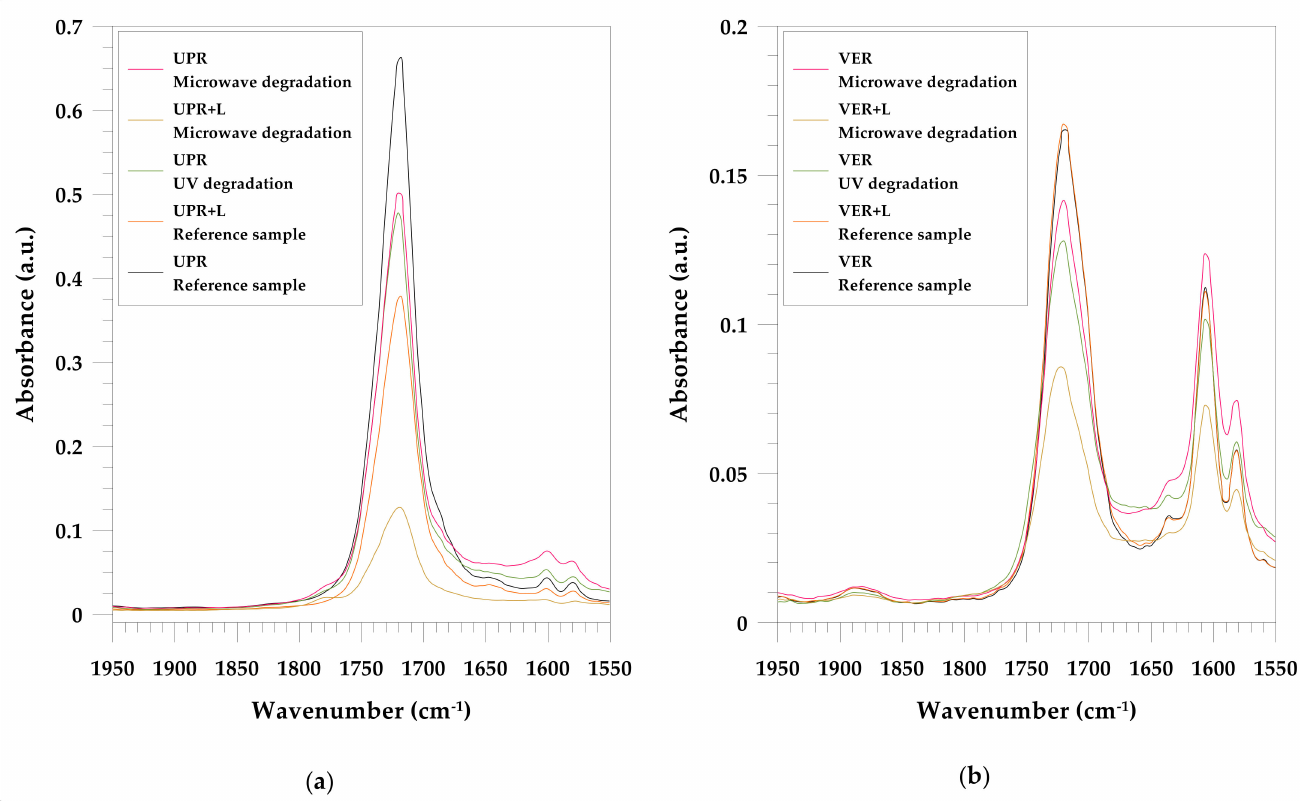
Figure 2. ATR/FT-IR spectra of the carbonyl vibrations’ region for: ( a ) UPR; ( b ) VER. The evolution in the two major wavenumber regions: 3400–3000 cm − 1 (hydroxylated groups) and 1900–1600 cm − 1 (carbonyl vibrations) reveals the formation of the oxida- tion